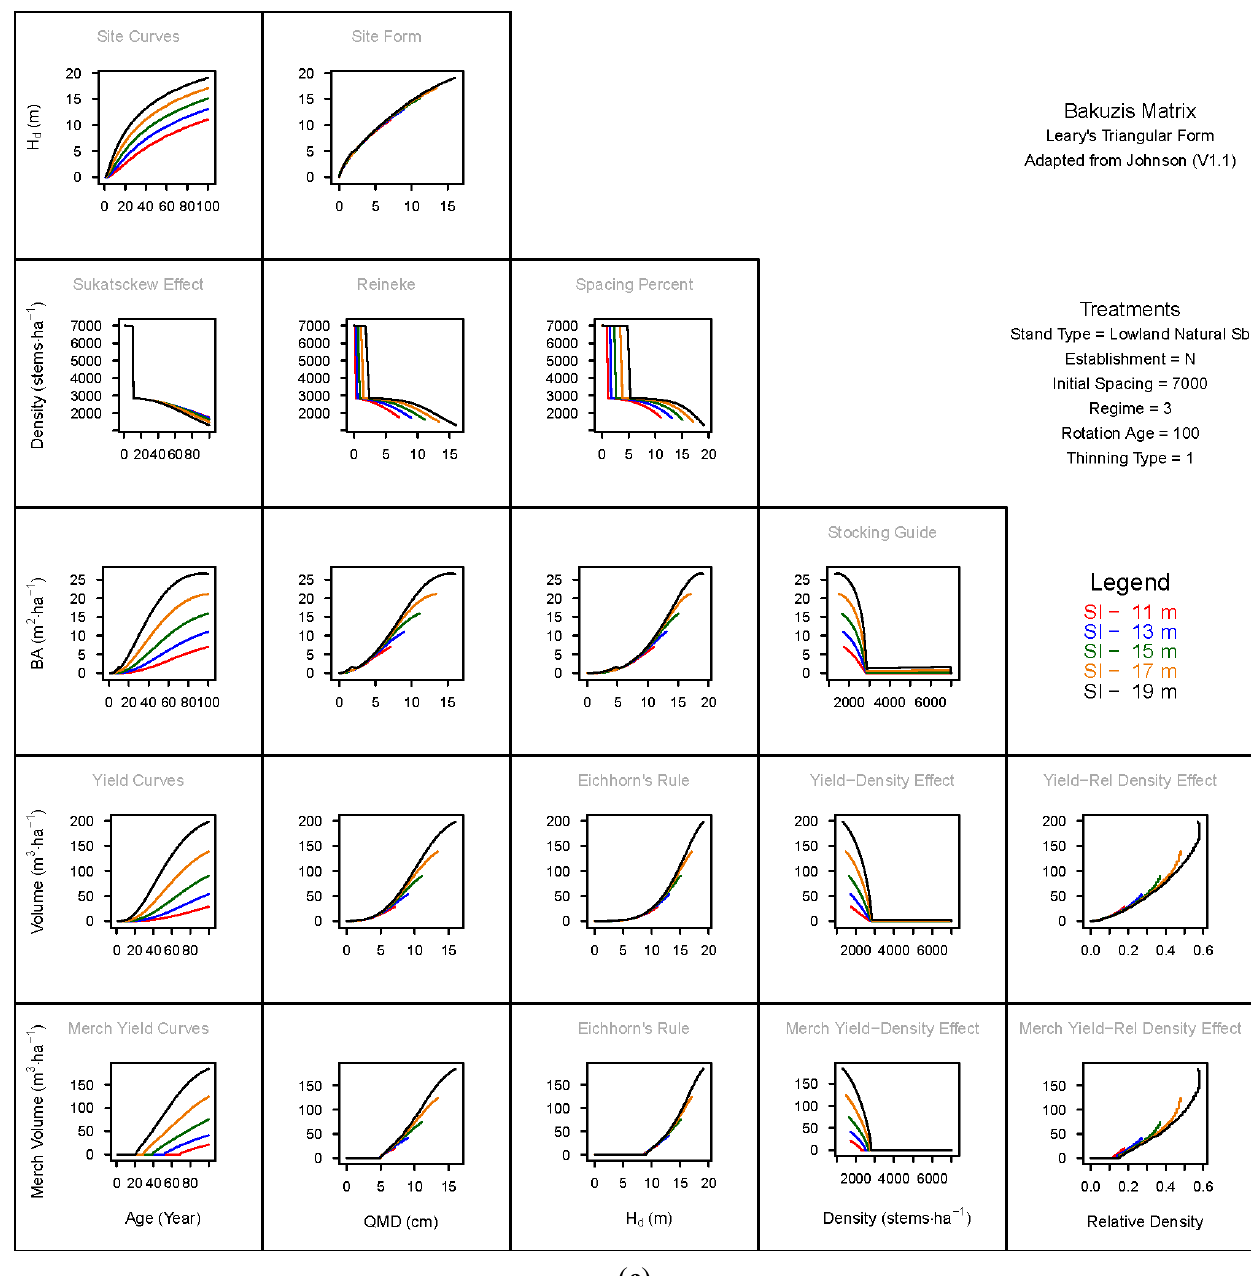
Figure A5. Bakuzis matrices for unthinned and precommercially thinned (PCT) lowland black spruce (Sb) stands which were established naturally (N) at an initial densities of 7000 stems/ha and grown on 5 site qualities (SI) over 100 year rotations: ( a ) Regime 1 represented unthinned control stands; ( b ) Regime 2 was initially identical to Regime 1 but the stands were subjected to a single PCT treatment at a stand age of 10 years in which stand densities were reduced to 2862 stems/ha and the maximum thinning response model setting was employed; and ( c ) Regime 3 was identical to Regime 2 but the stands utilized the minimum thinning response model to account for accelerated growth arising from the PCT